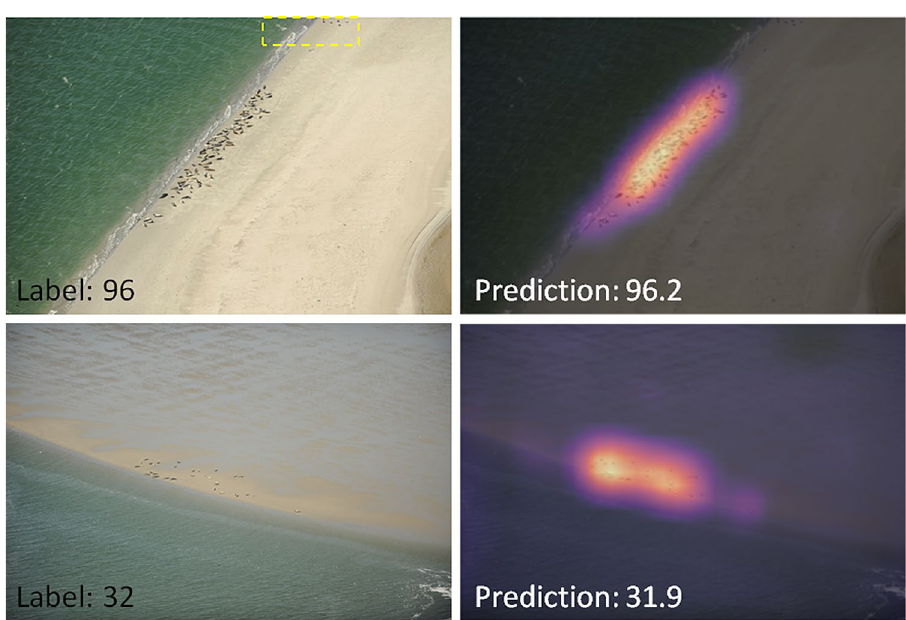
Figure 4. Examples of images (left) and CAMs (right), with good performance from the seal test set. Notice that in the top example some birds are visible (yellow dotted line), which are not counted by the model, which has specialised on